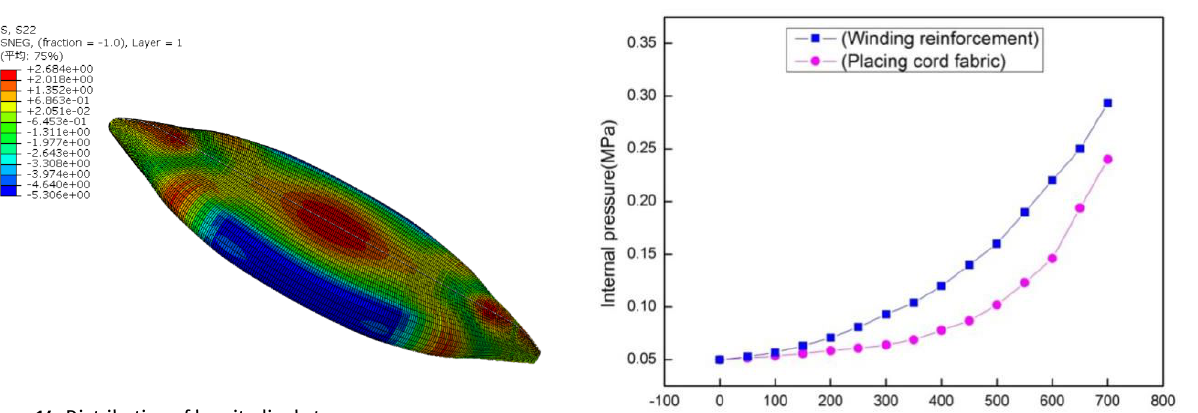
Figure 14: Distribution of longitudinal stress